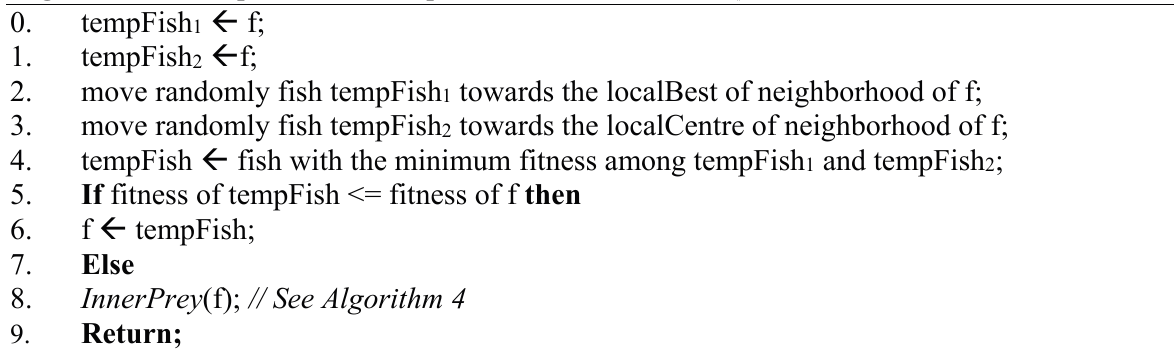
Algorithm 5: The pseudo code of procedure SwarmNChase()